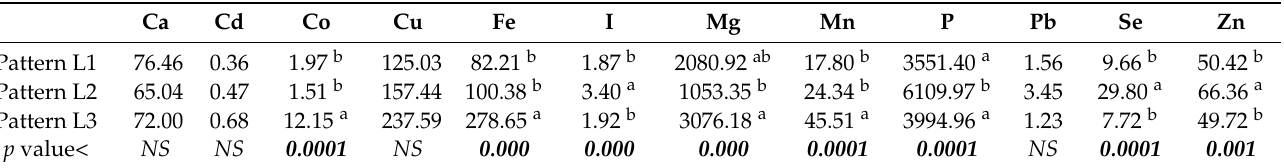
Table 10. Mean values of minerals in camel liver according to the patterns based on Ascending Hierarchical Classification patterns [µg/g wet weight].